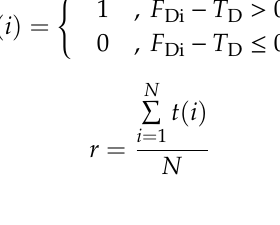
Figure 5. ( a ) Detection function of different anomalies; ( b ) detection function of different anomalies in a single diagnosis period.